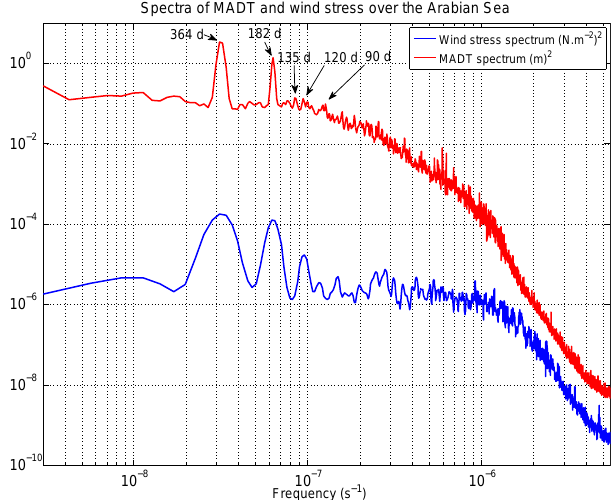
Figure 3. Spectra of 22 years of sea-surface height (SSH) (red, (m) 2 ) and 40 years of wind stress (blue, (Nm − 2 ) 2 ). The spectra are averaged over 15–27 ◦ N, 54–75 ◦ E. The periods for the major spectral peaks are